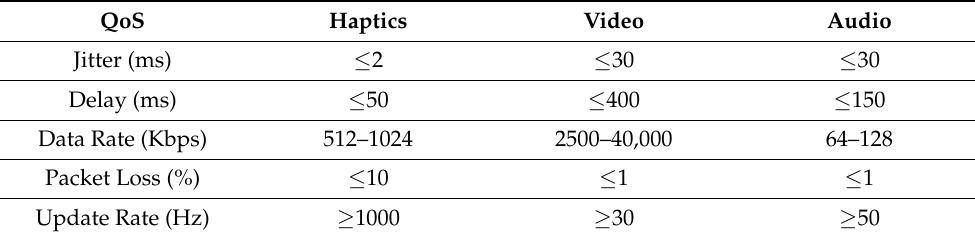
Table 2. Network